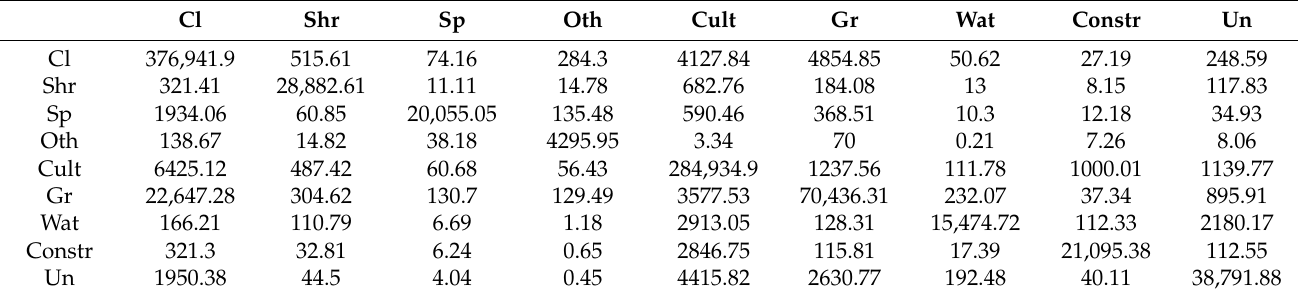
Table 10. Conversion of Land Types from 2020 to 2050EP (km 2